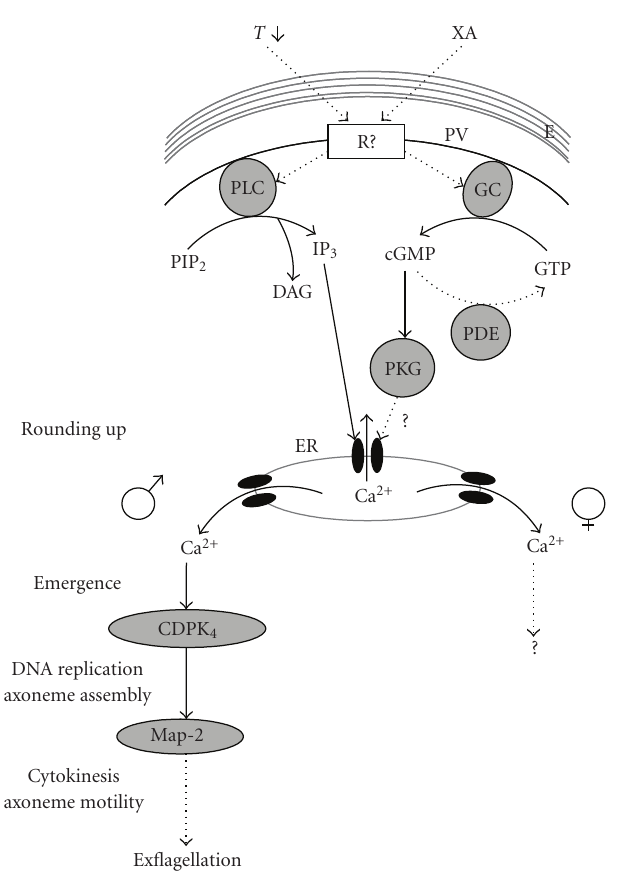
Figure 2: Schematic overview of signaling pathways identified to date that are involved in gametocyte activation (modified from [83]). Gametocyte activation is induced by a decrease in temperature and the presence of the mosquito-derived molecule XA. So far, a receptor involved in activation has not been identified. Activation e ff ects PLC and GC, resulting in an increase of IP 3 and cGMP. The latter activates a PKG. IP 3 mediates release of intracellular calcium from the ER, which activates CDPK4 and consequently Map-2 in the male microgametocyte, eventually leading to exflagellation. A possible link between PKG and calcium release has not yet been confirmed. Signaling pathways in the activated macrogametocyte that are downstream of calcium release were not yet identified. Black lines indicate direct interactions and dashed lines indicate indirect interactions. Ca 2+ , calcium ion; CDPK, calcium-dependent protein kinase; cGMP, cyclic guanosine monophosphate; DAG, diacylglycerol; DNA, deoxyribonucleic acid; E, erythrocyte; ER, endoplasmic reticulum; GC, guanylyl cyclase; GTP, guanosine triphosphate; IP 3 , inositol triphosphate; Map-2, Mitogen-activated protein kinase 2; PDE, phosphodiesterase; PIP 2 , phosphatidylinositol-4,5-bisphosphate; PKG, cGMP-dependent protein kinase; PLC, phospholipase C; PV, parasitophorous vacuole; R, receptor; T, temperature; XA, xanthurenic